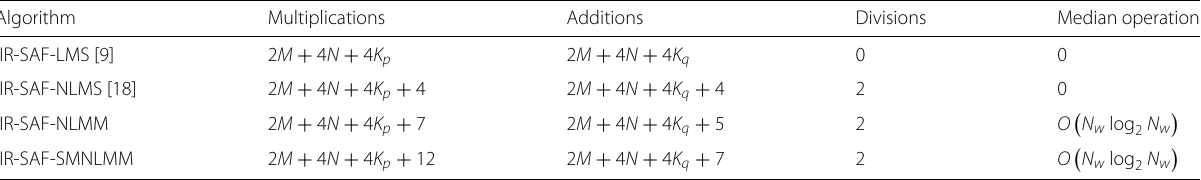
Table 1 Comparison of the computational complexities